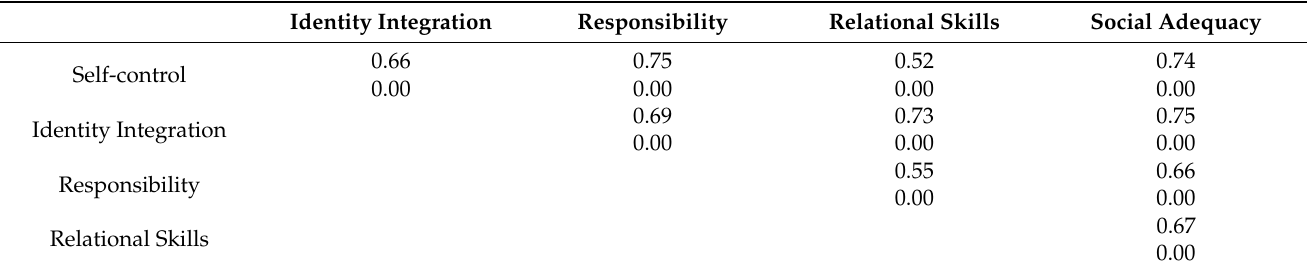
Table 1. Pearson correlation matrix for domains investigated through the personality traits